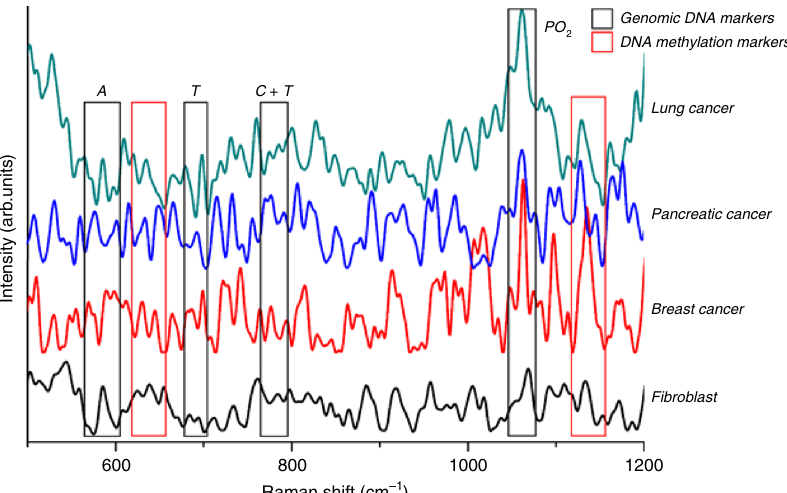
Fig. 4 Single-molecule analysis of genomic DNA to determine base composition and DNA methylation from a single SERS measurement. SERS spectra of genomic DNA showcasing the markers for DNA base composition analysis and DNA